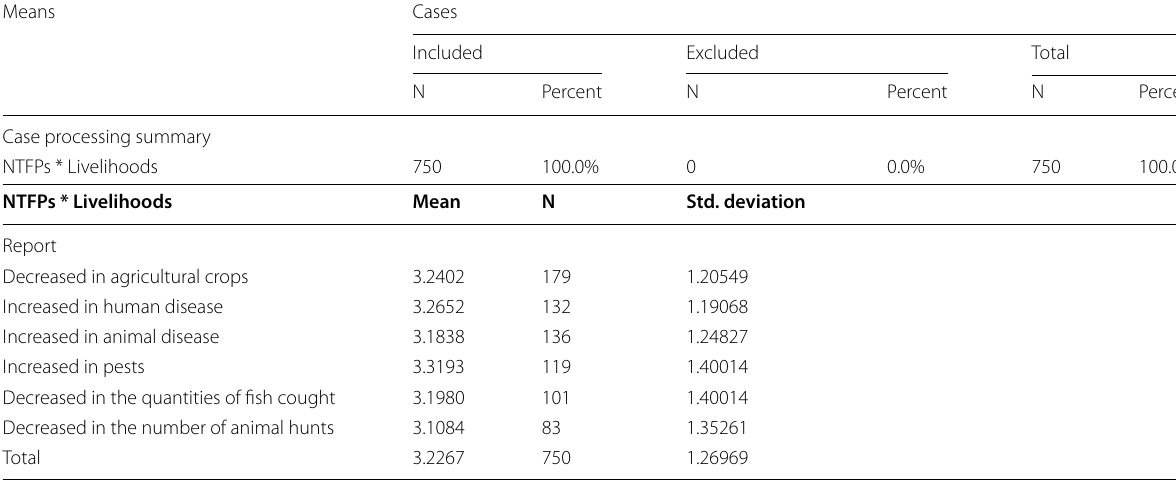
Table 4 The Means and std deviation of climate change impacts on livelihoods